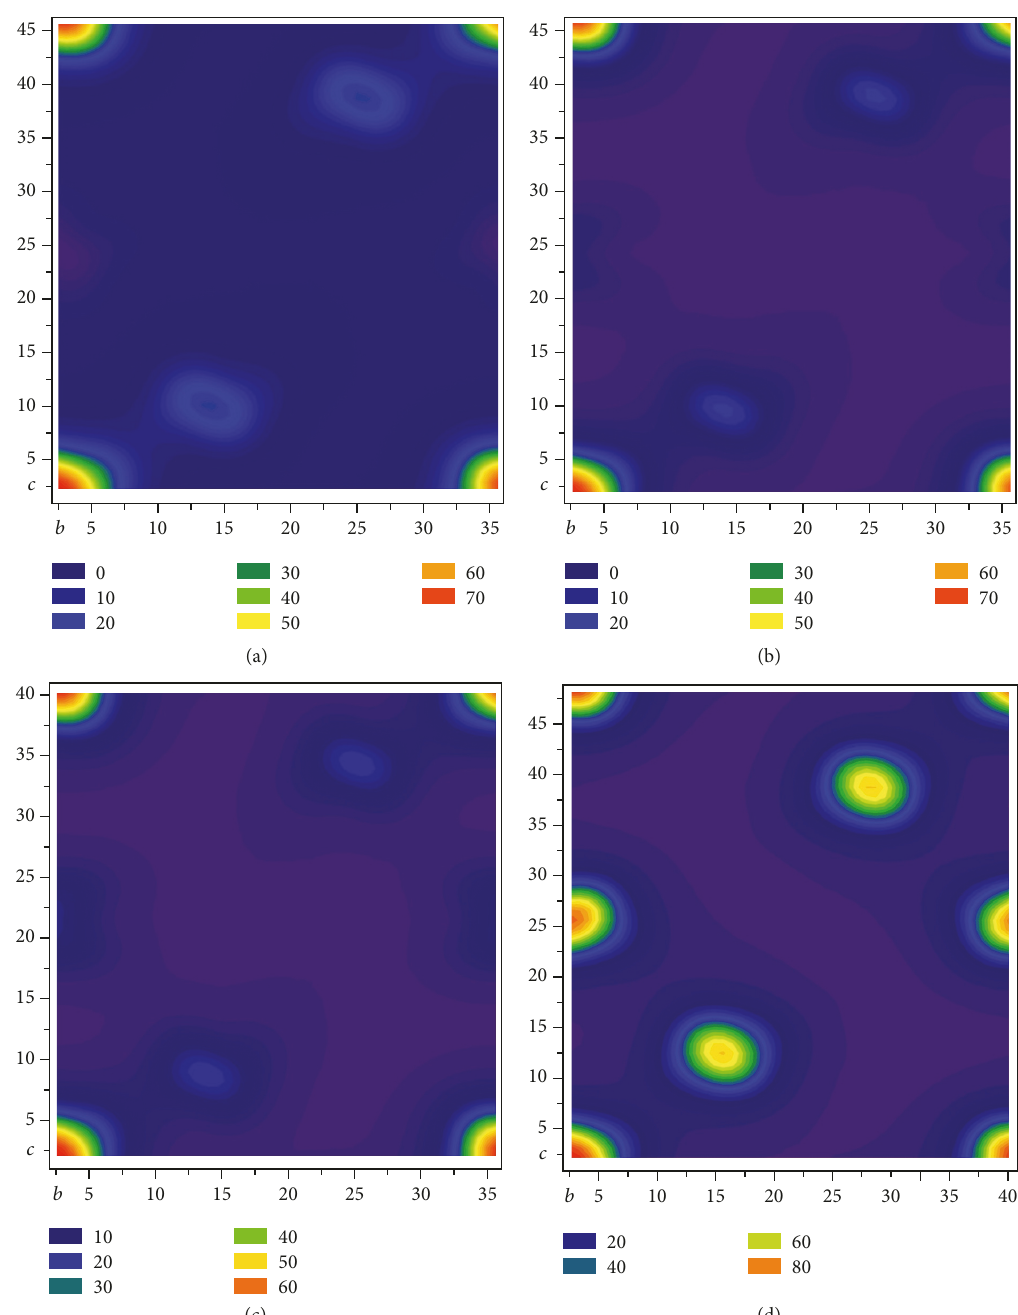
Figure 3: Spin density distributions of bulk Fe 2 Si under various strains: (a) 0%, (b) − 11% to 11% (excluding zero strain), (c) 12%, and (d) − 12%.